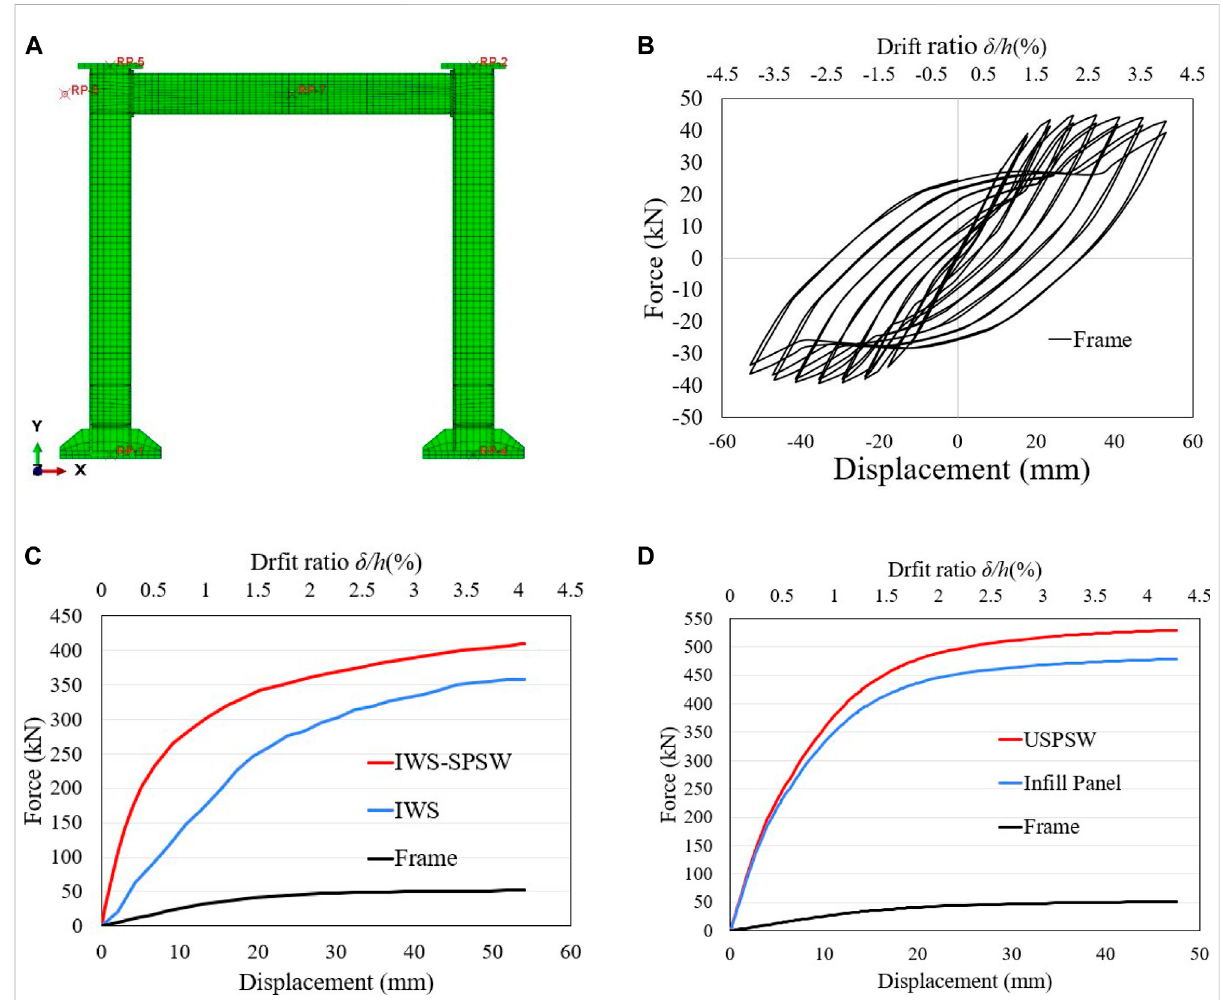
FIGURE 18 Cyclic and pushover response of frame with and without in fi ll strips and in fi ll panel: (A) FE model of the frame without in fi ll panel, (B) hysteresis loops of the frame, (C) frame contribution in the IWS-SPSW, (D) frame contribution in the USPSW.